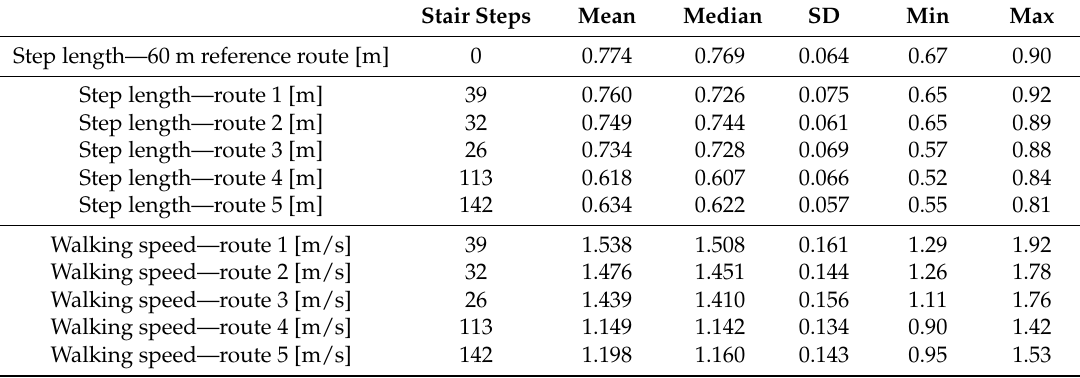
Table A1. Results of the field test for all five routes measured in the railway station.